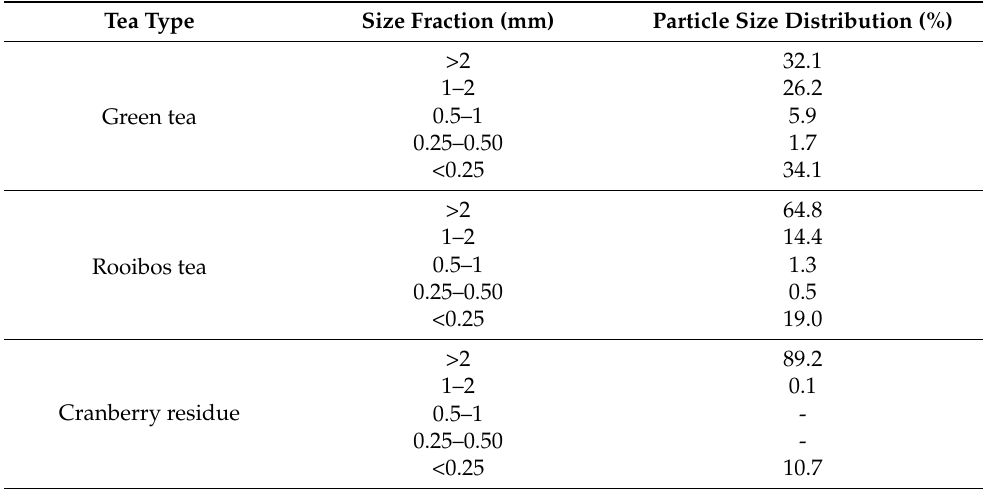
Table 2. Particle size distribution of the control tea litters and cranberry